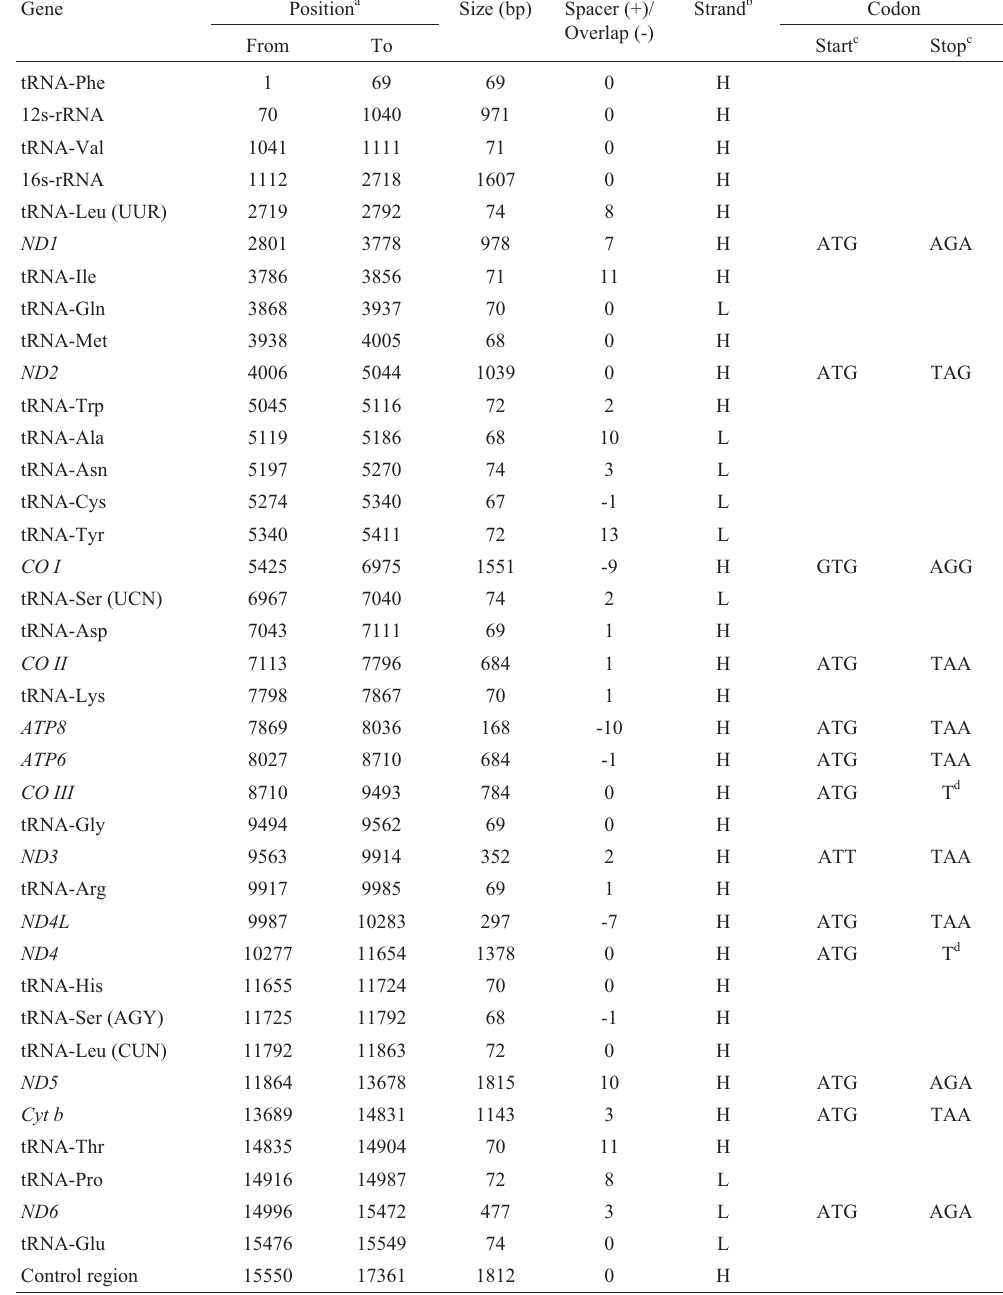
Table 1 - Organization of the E. garzetta mitochondrial